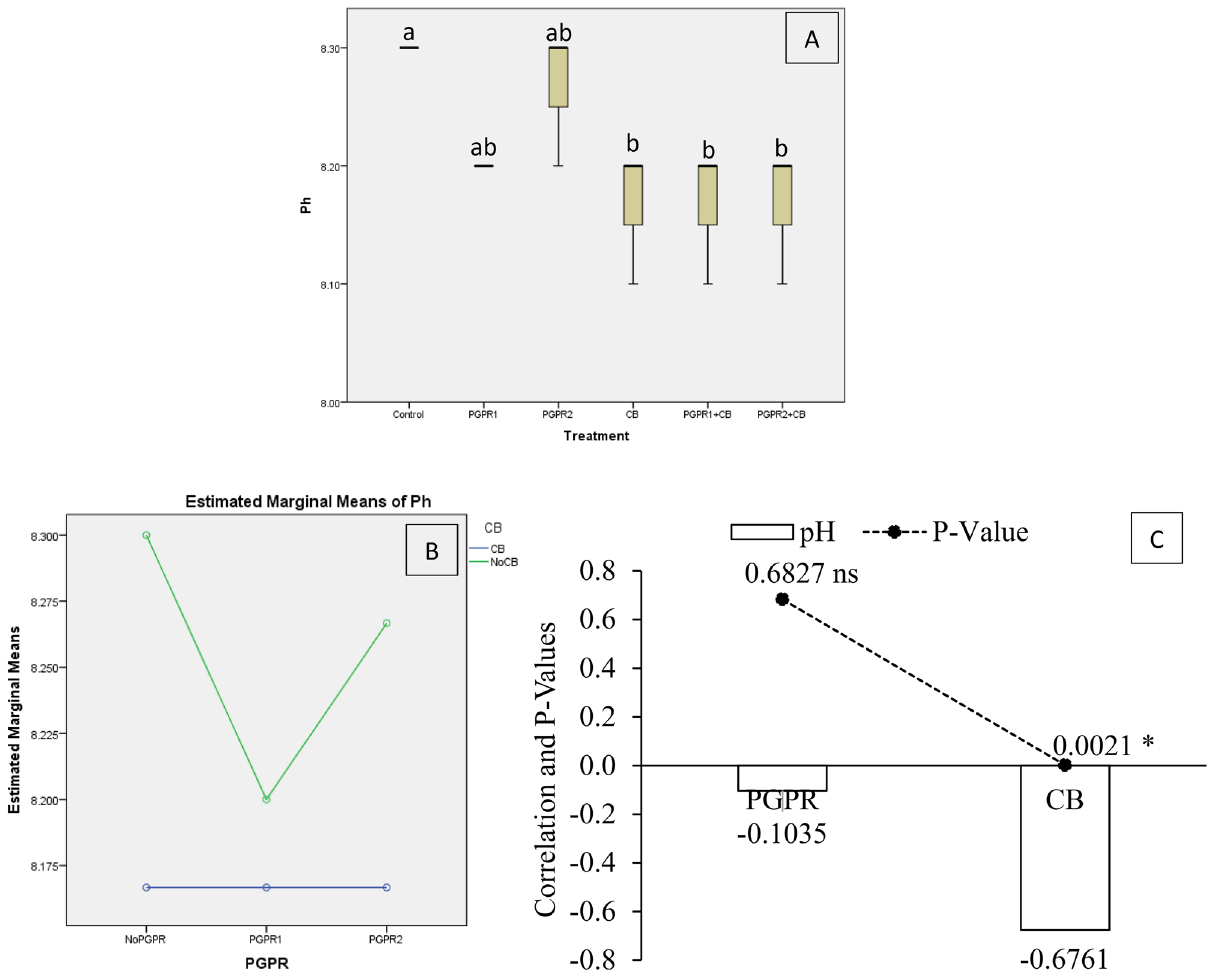
Figure 1. Effect of treatments on pH of soil. Values are the average of three replicates ( A ). Different letters showed significant differences (Tukey’s test; p ≤ 0.05). Interaction graph of PGPR and CB for soil pH s ( B ). Correlation graph of PGPR and CB for soil pH s ( C